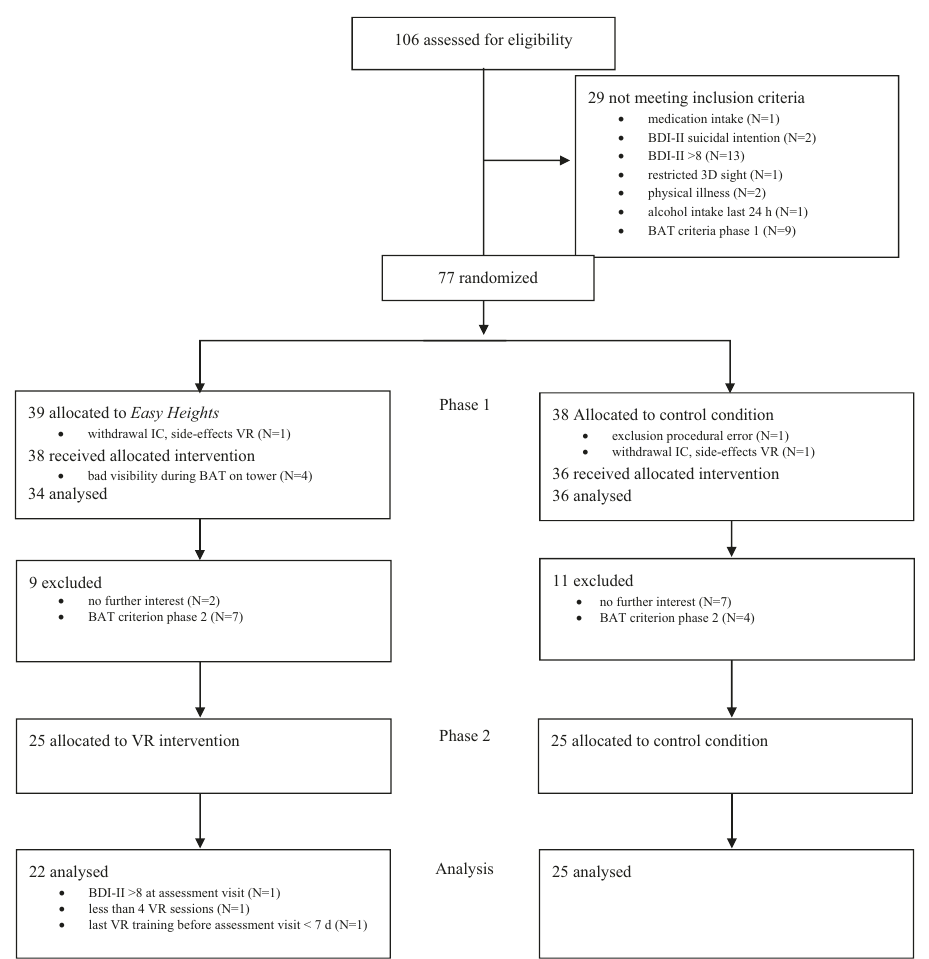
Fig. 1 Flowchart of participants — CONSORT. BDI-II Beck Depression Inventory, BAT Behavioural Avoidance Test, VR Virtual Reality, IC Informed